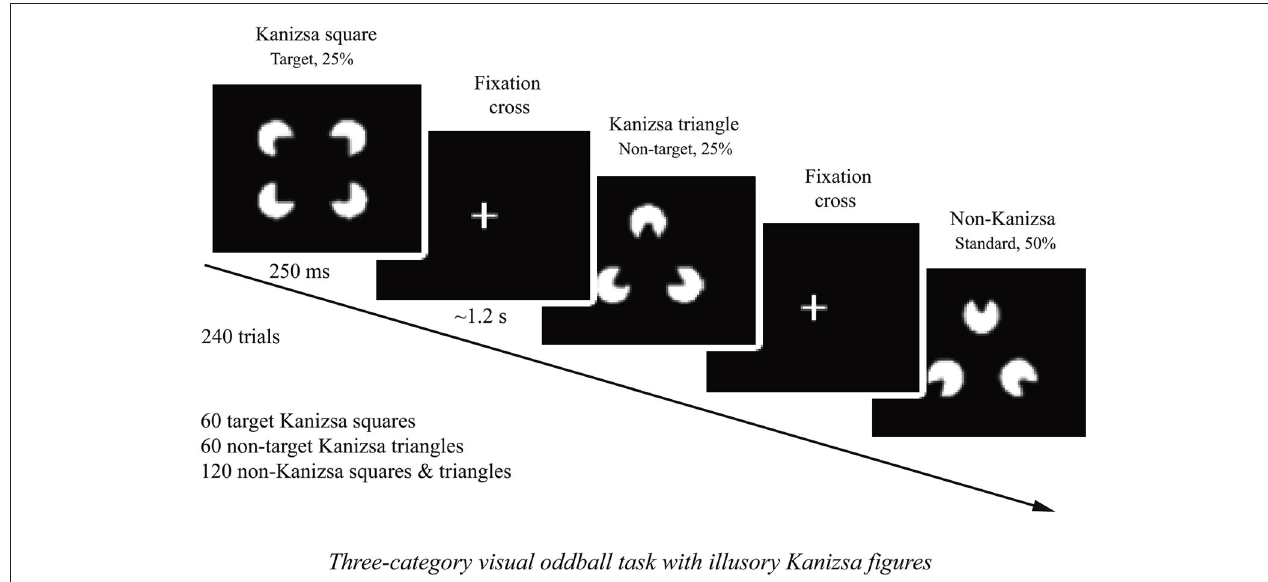
of Kanizsa figures and targets. The stimuli consist of either three or four inducer disks, which are considered the shape feature, and they either constitute an illusory figure (square, triangle) or not (collinearity